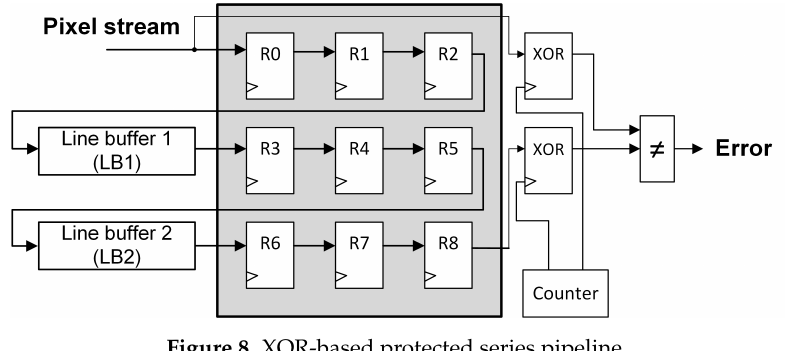
Figure 8. XOR-based protected series pipeline.